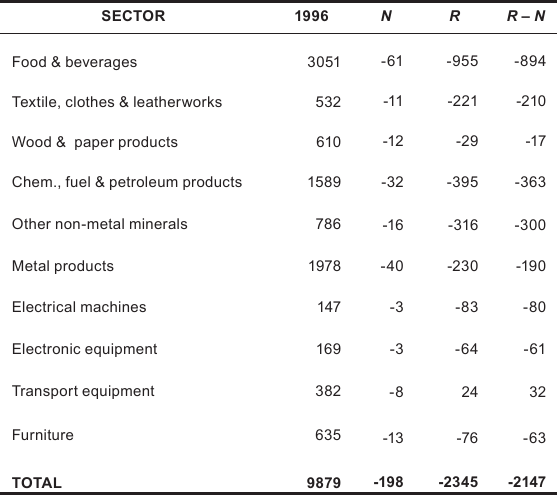
Table 3 National share effect (n) in the Southern District Municipality